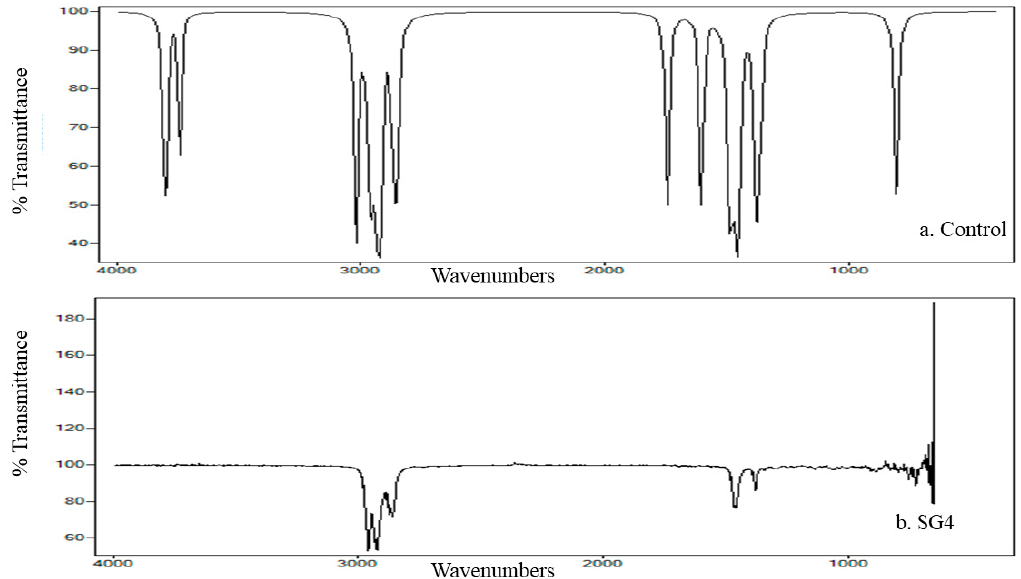
Figure 4. FTIR analysis of cypermethrin degradation with strain SG4 in minimal salt medium.